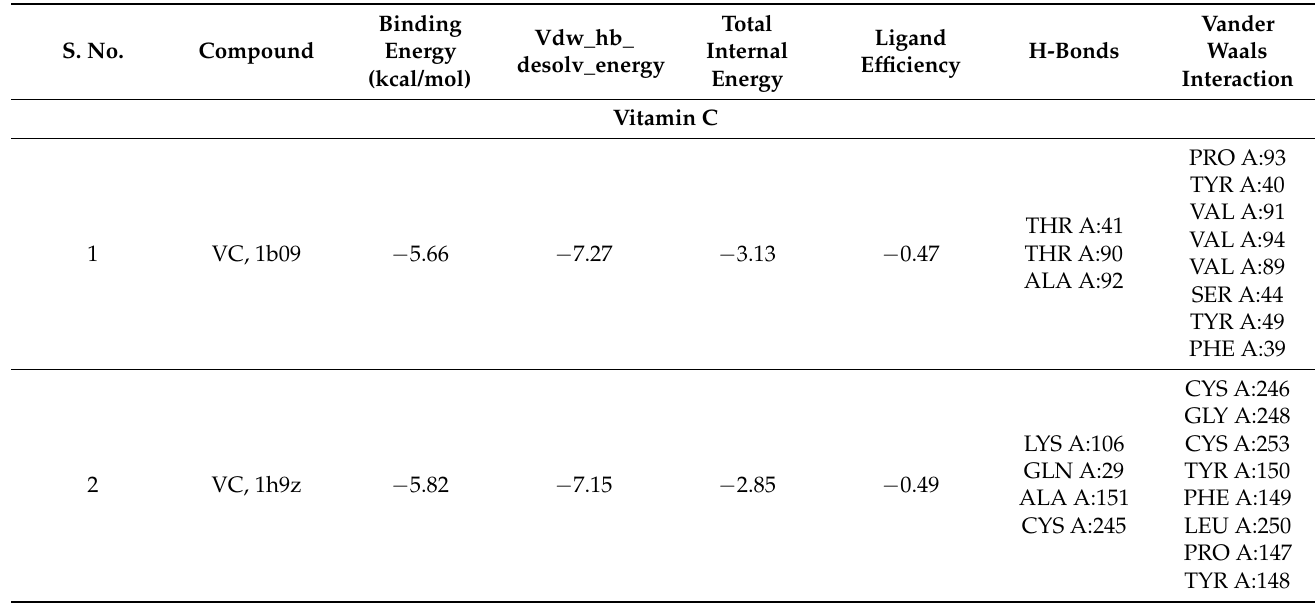
Table 1. Docking parameters of vitamin C, β -carotene, and lycopene.